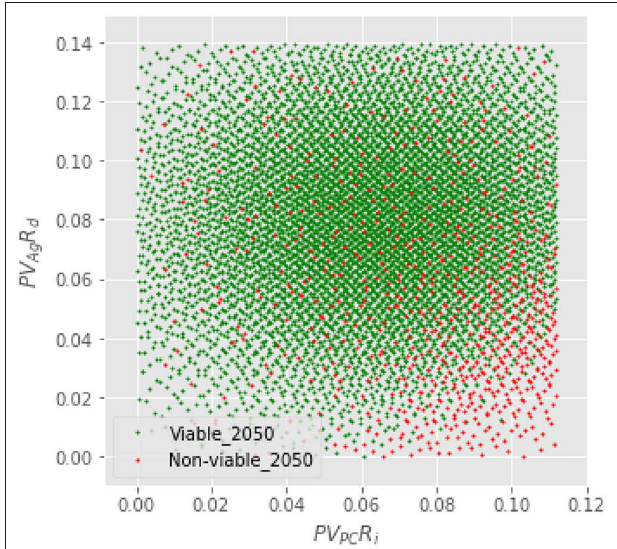
FIGURE 10 | Viable (green) and non-viable (red) scenarios in the year 2050. The coordinates of each points are the values of the parameters (PV PC R i , PV Ag R d ) used in a given simulation. Monte Carlo simulations run on 8,192 quasi-random samples.